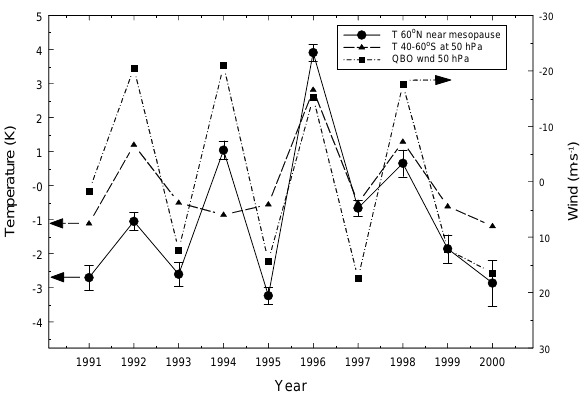
Fig. 2. The summer mesospheric temperature anomaly near 87km (circle-solid line), winter stratospheric temperature anomaly at 50hPa (triangle-dashed line) and the QBO wind anomaly at 50hPa (square-dashed and dotted line) as a function of year. For the winds, negative denotes an easterly (towards the west) direction, and the axis has been reversed.